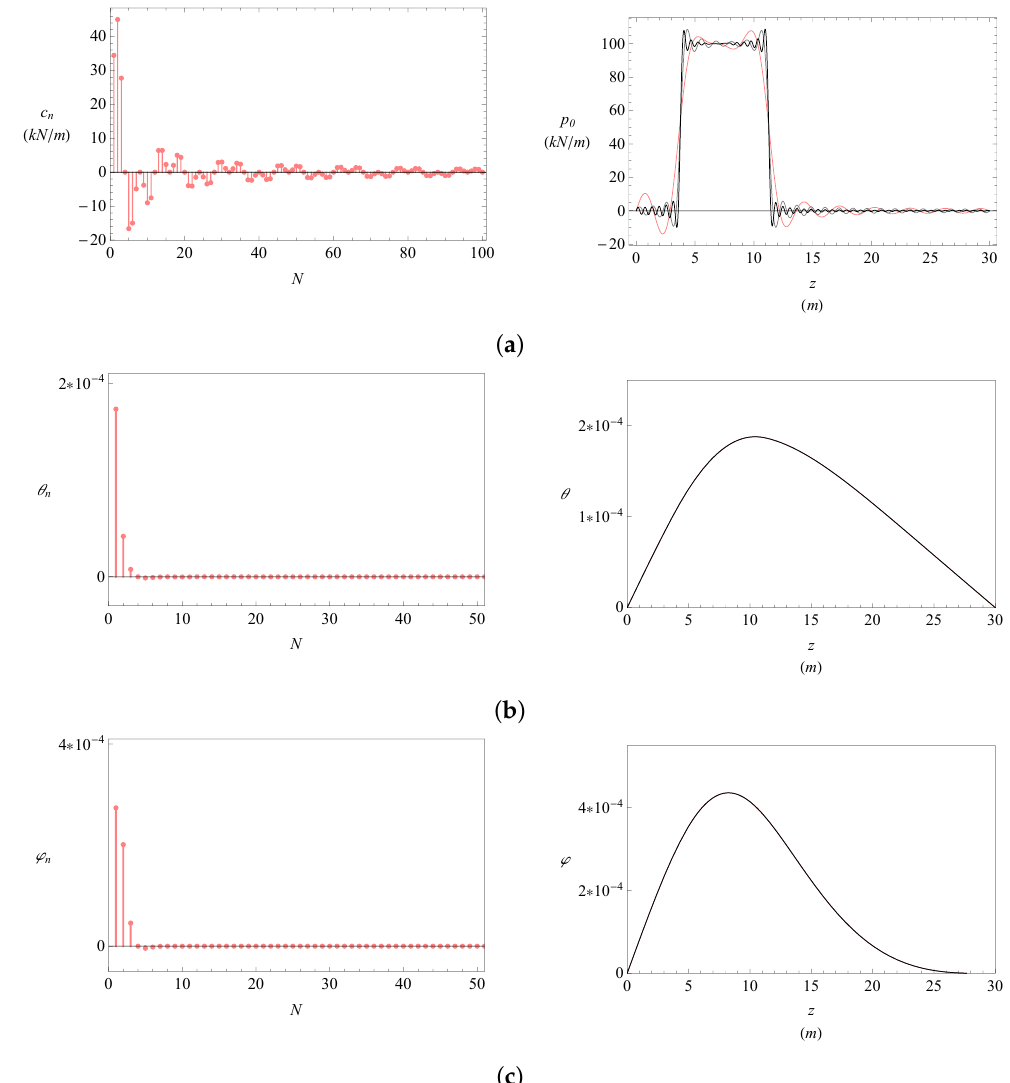
Figure 13. Fourier coefficients and truncated series for ( a ) loads, ( b ) twist angle, and ( c ) distortion. The simplified method was successively applied by uncoupling the GBT